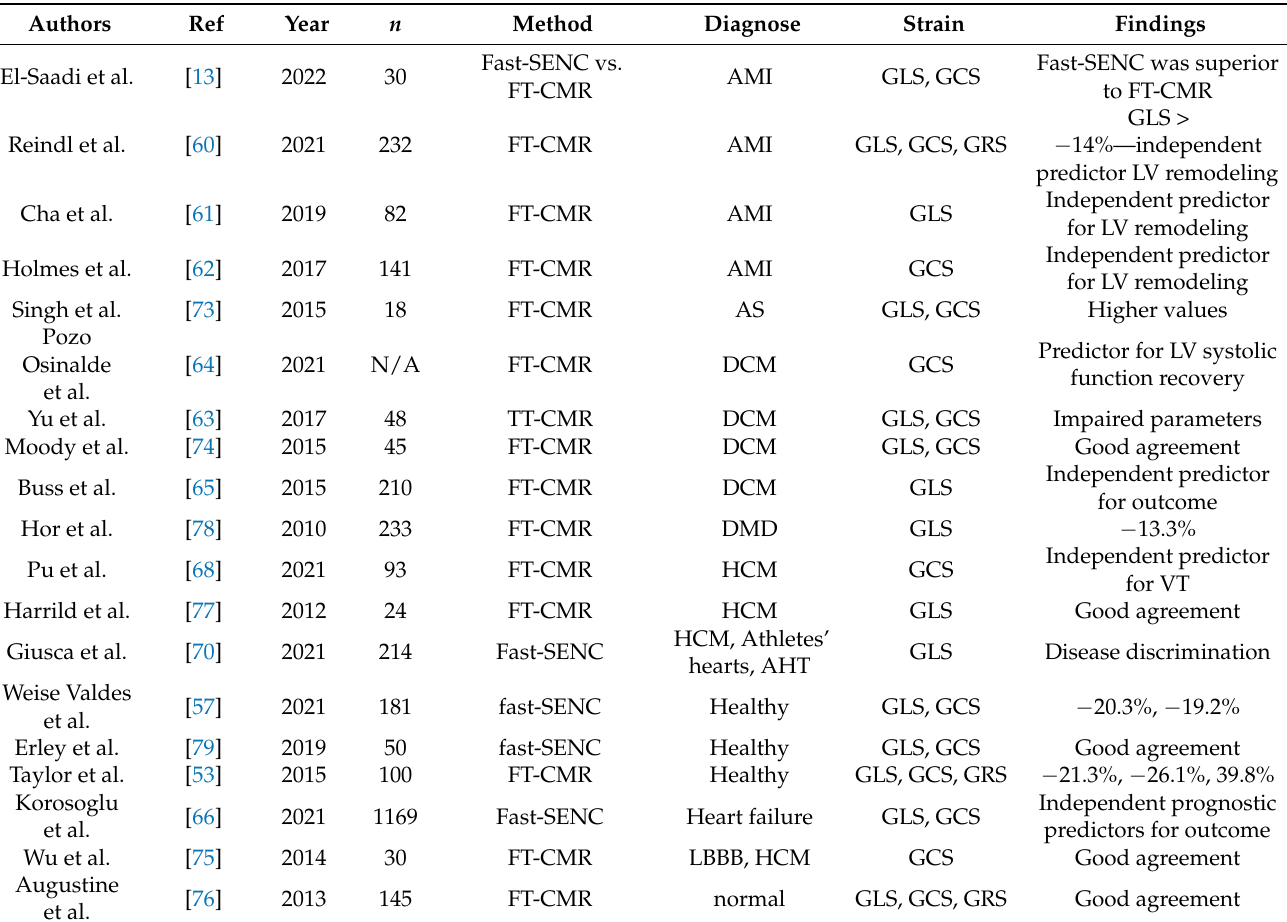
Table 3. LV myocardial strain assessed by various CMR